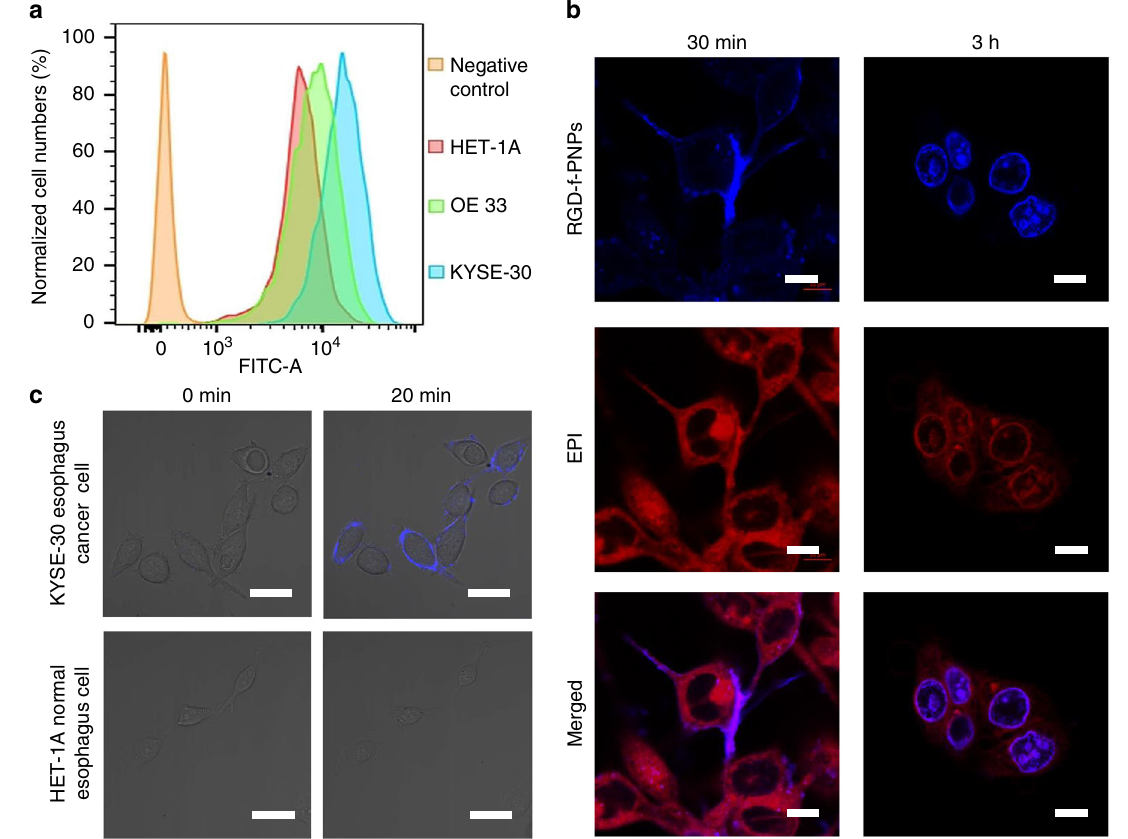
Fig. 3 In vitro targeted EC cell imaging and enhanced internalization. a Flow cytometry of HET-1A, OE33, and KYSE-30 cells indicates that the α v β 3 integrins are overexpressed in EC cells. The fl uorescence signals from OE33 and KYSE-30 cells shifted clearly to right compared to that from HET-1A cells, indicating that EAC and ESCC cell lines contain higher expression of plasma membrane integrin α v β 3 than HET-1A cells. b Confocal fl uorescence images of the KYSE- 30 cells after incubation with RGD-f-PNPs/EPI conjugates for 30 min and 3 h. The blue and red color represents the fl uorescence signal of the RGD-f-PNPs and EPI, respectively. After 30 min of treatment, a signi fi cant blue fl uorescence was observed from the KYSE-30 plasma membranes, which can be attributed to the binding between the RGD peptide moieties and overexpressed integrins at the plasma membrane. The data suggest that RGD peptide moieties could enhance the speci fi c binding between RGD-f-PNPs and plasma membrane integrins. After 3 h of the treatment, clear red fl uorescence was observed at the cell nucleus, indicating that RGD-f-PNPs/EPI has internalized into the cell nucleus. Scale bar: 10 μ m. c Confocal fl uorescence images of KYSE-30 and HET1-A cells incubated with RGD-f-PNPs after 0 and 20 min. A signi fi cant blue fl uorescence of the RGD-f-PNPs was only observed from the KYSE-30 cell membrane after 20 min of treatment, which can be attributed to the speci fi c binding between RGD moiety and integrin on the cell membrane. The data suggest that RGD-f-PNPs can selectively target EC cells vs. normal epithelial cells. Scale bar: 20 μ